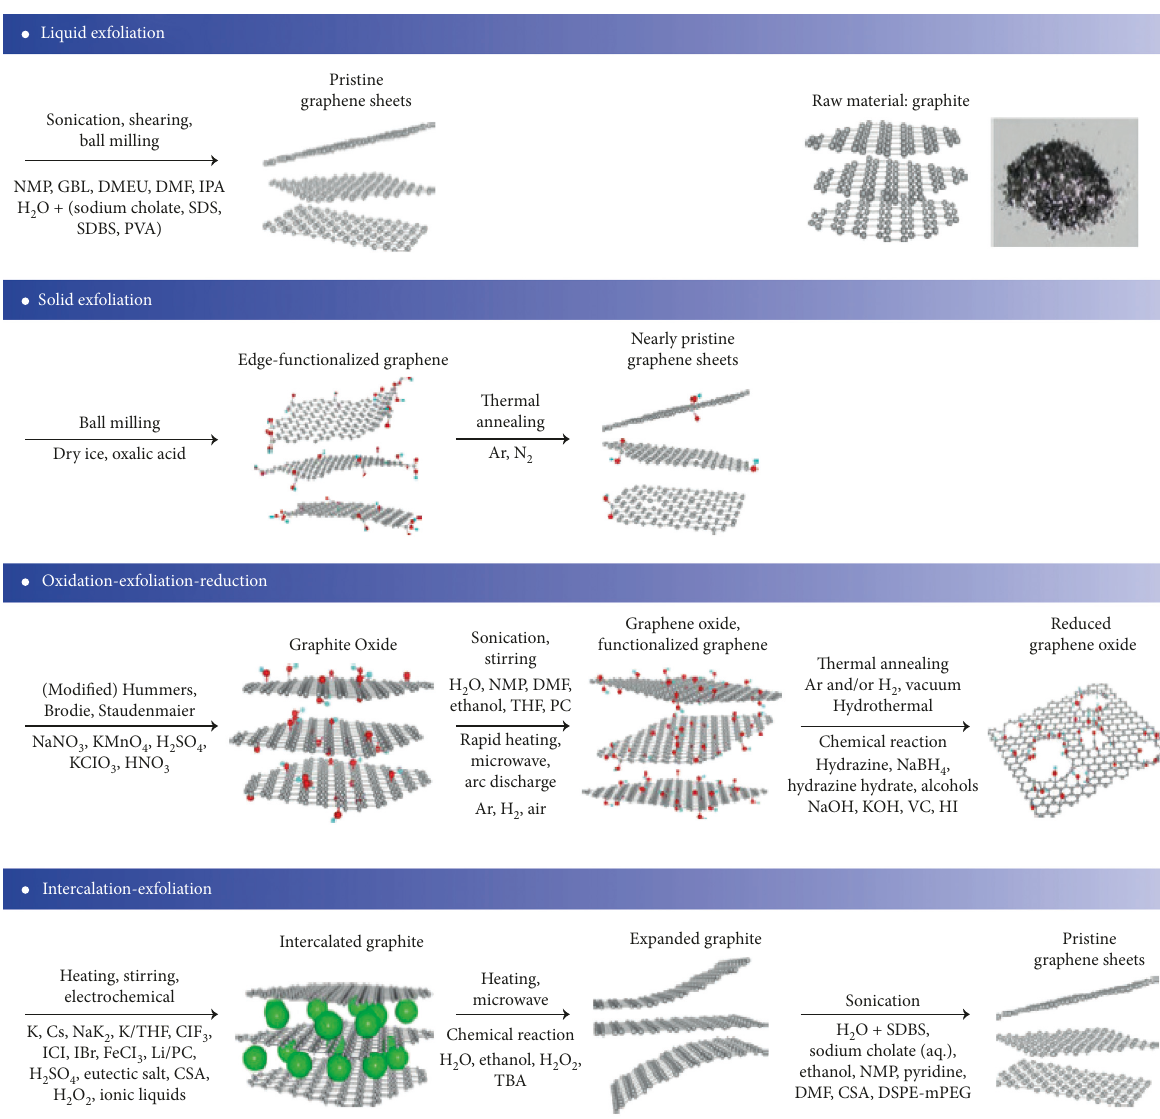
Figure 18: Four types of methods in the synthesis of small graphene sheets by